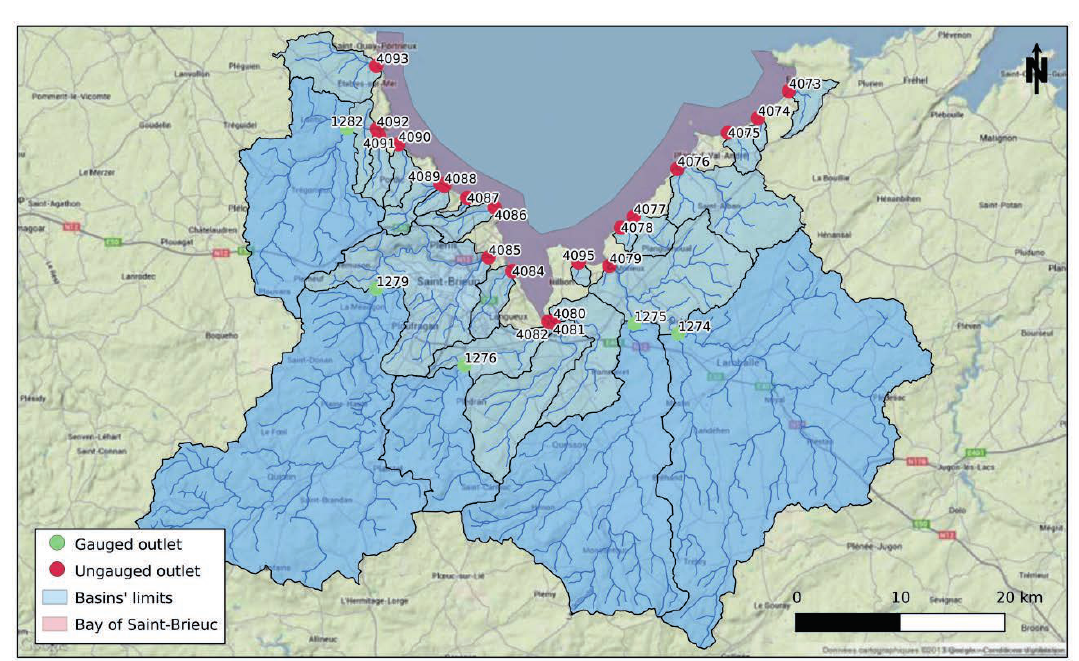
Fig. 1 Saint-Brieuc Bay with gauged and ungauged basins’ outlets named by their identifying number (ID). Background map 2013